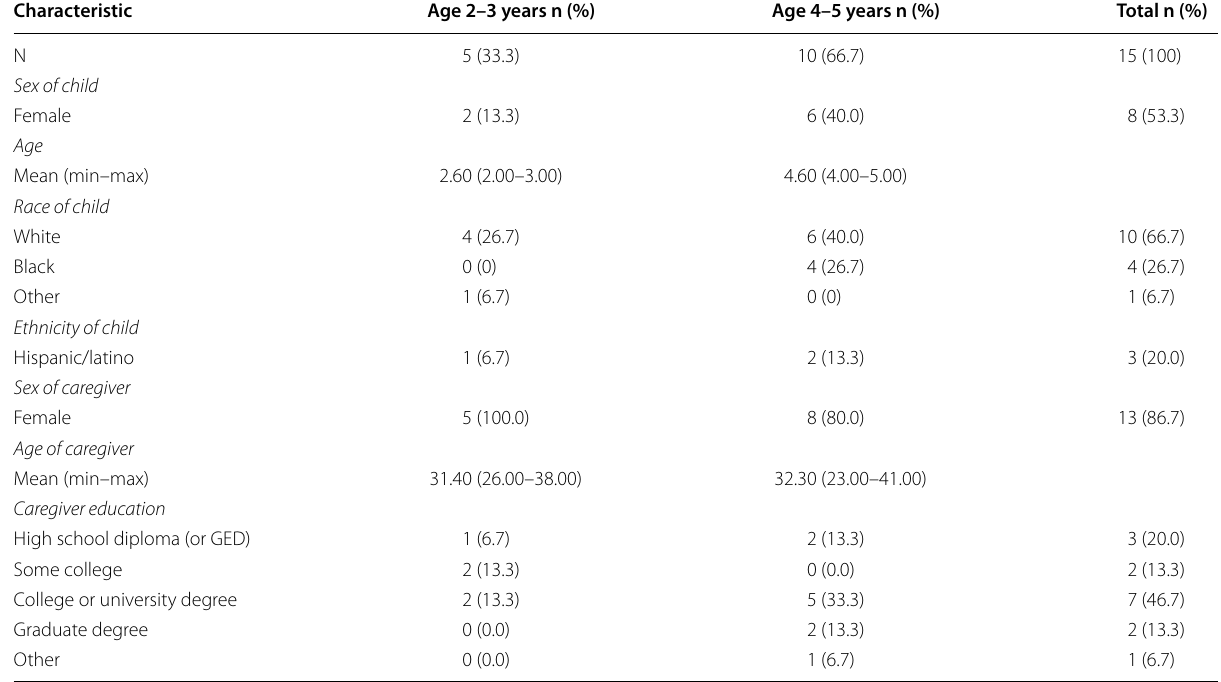
Table 1 Demographic characteristics of children and